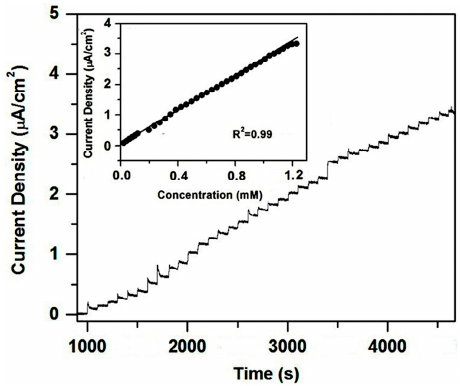
Figure 6. ( a ) CVs of CuO/CeO 2 /ITO electrode in 0.1 M PB solution containing 5 mM glucose at different scan rate; ( b ) Plot of the peak current with square root of the scan rate.